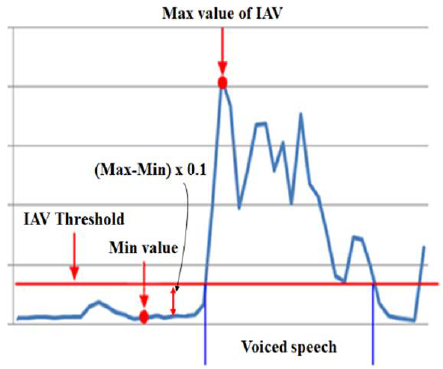
Figure 4. An example of determining threshold